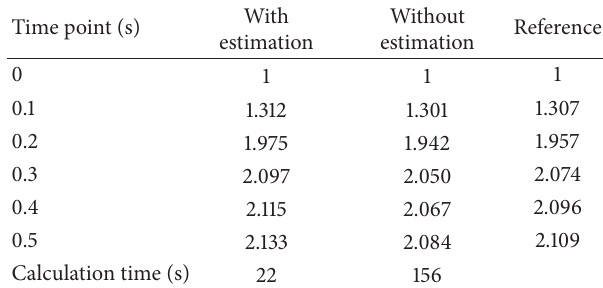
Table 7: Normalized power versus time with different time step in TWIGL problem during step perturbation.